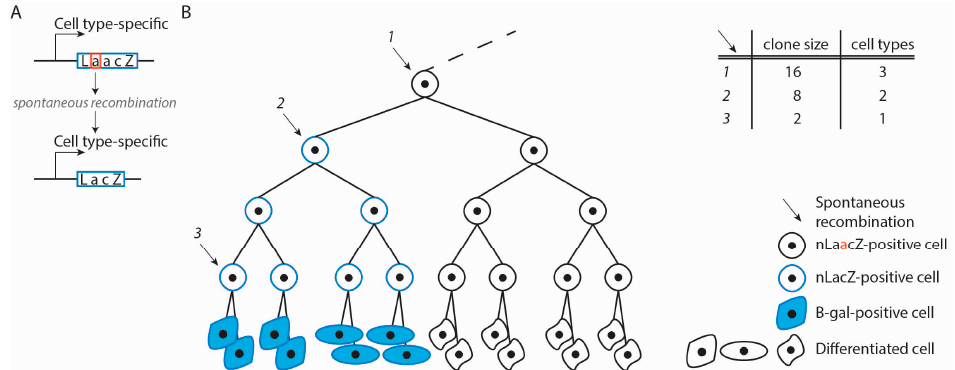
Figure 3. Retrospective clonal analysis using the transgene nLaacZ . ( A ) The nLaacZ transgene harbors an intergenic duplication resulting in a truncated coding sequence. A rare spontaneous recombination event removes the duplication, thereby generating a functional LacZ gene encoding nuclear localized β -galactosidase; ( B ) Schematic representation of nLaacZ -based retrospective clonal analysis visualizing one recombination event (2). Spontaneous recombination of the nLaacZ transgene can occur in any cell and at any time during development and labels a cell and its descendants. The descendants form a clone because they originate from the same cell. Clone size is proportional to the time between recombination and analysis. Labeling of a more undifferentiated cell early in development (1) results in a bigger clone consisting of several cell types compared to labeling at a later developmental stage in a more fate restricted cell (2 and 3). A temporal history of a lineage is reconstructed by characterizing multiple clones that differ in size, distribution and cell type.